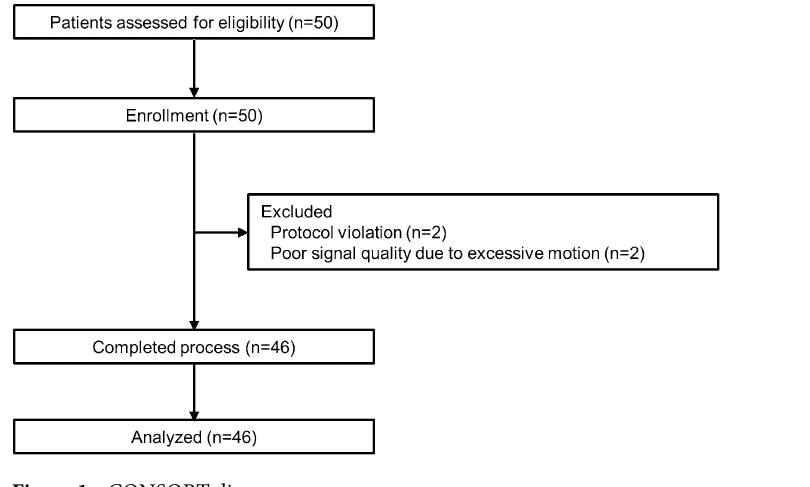
Figure 1. CONSORT